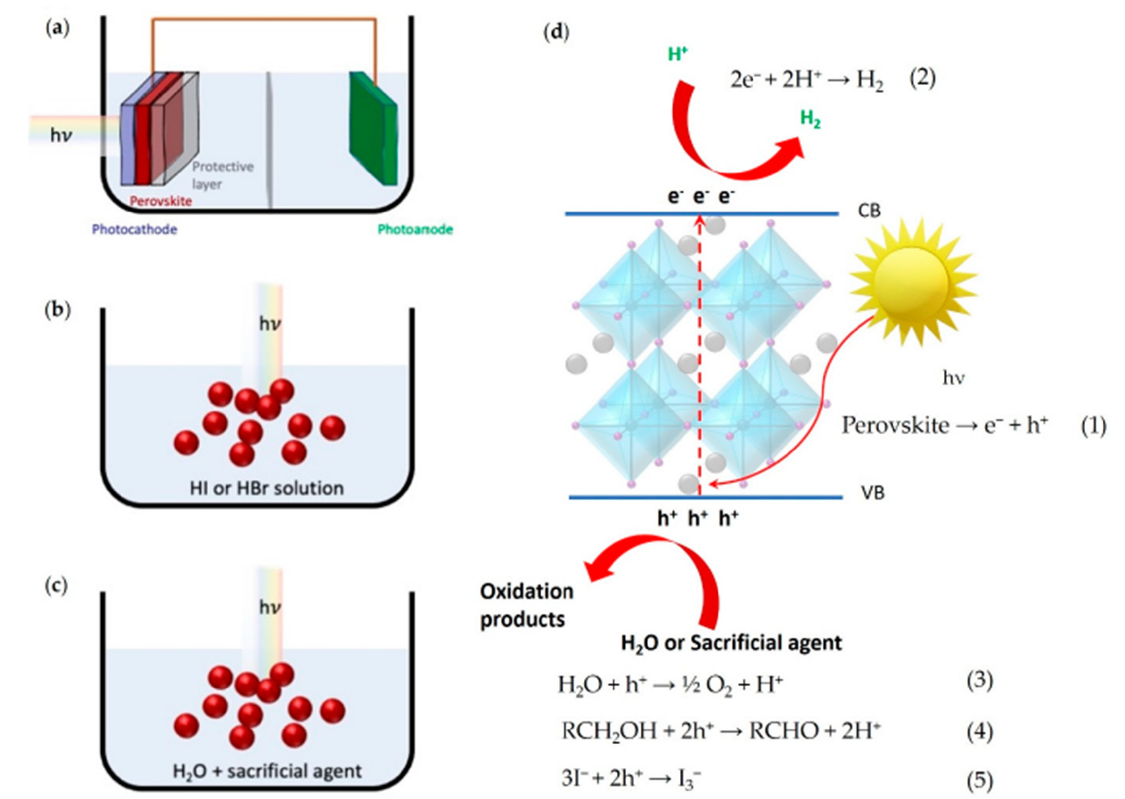
Figure 2. Solar-driven perovskite-based H 2 production system: ( a ) photoelectrochemical (PEC) cell; ( b ) particulate photocatalyst system in dynamic equilibrium with the corresponding halogen acid; ( c ) particulate water-stable photocatalyst system. ( d ) Schematic representation of the processes on the perovskite photocatalyst surface under irradiation and possible reactions involved in the different systems [19].